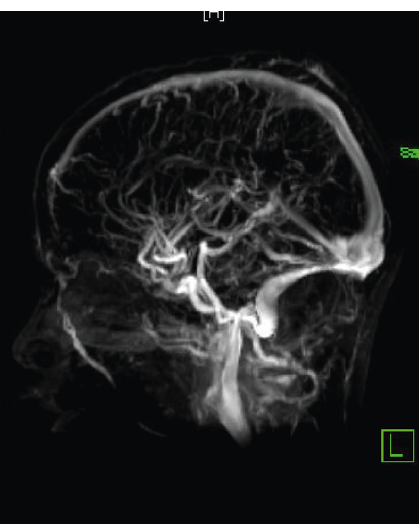
Figure 4: MRV of the brain, showing filling defects in the transverse, sigmoid, and internal jugular